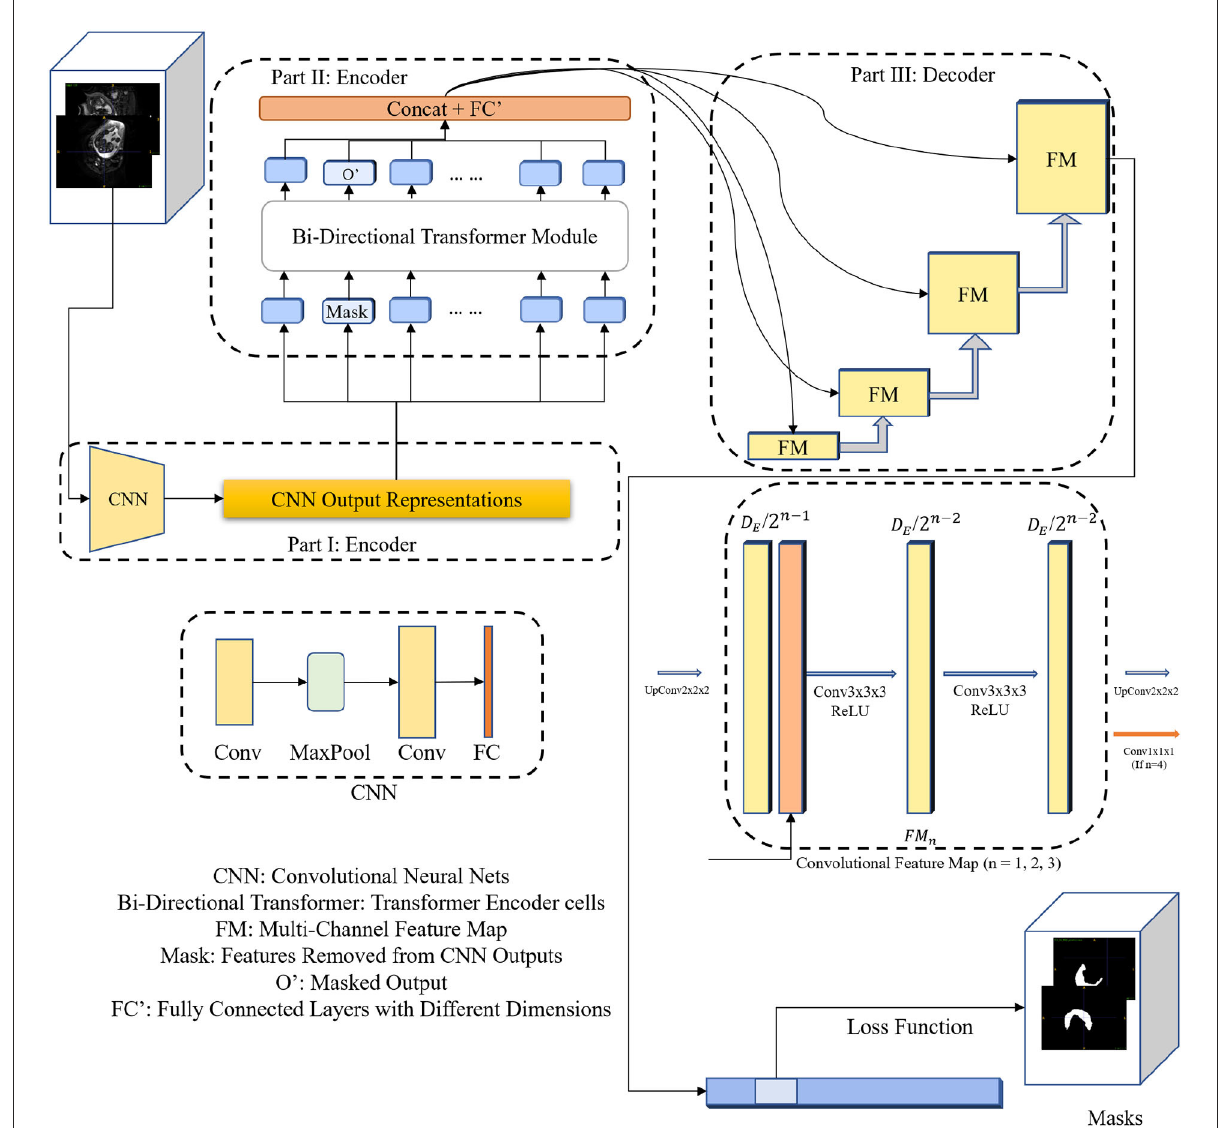
FIGURE1 The diagram of the 3DTU framework in an encoder–decoder setting. The encoder consists of two parts including feature extraction and bi-directional